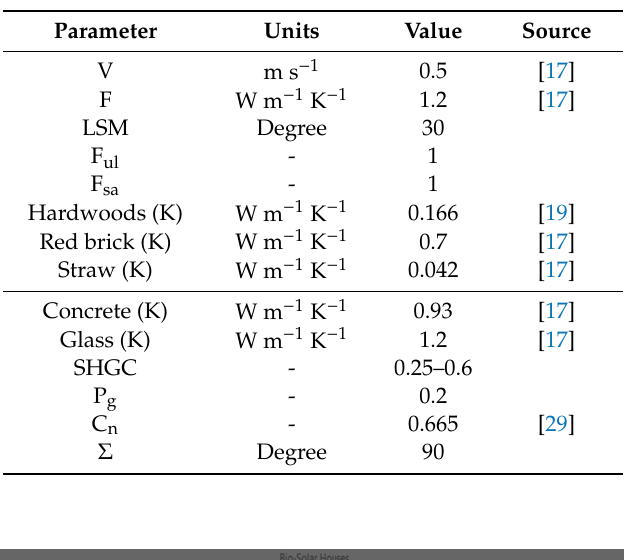
Table 1. Parameters used in the energy balance.